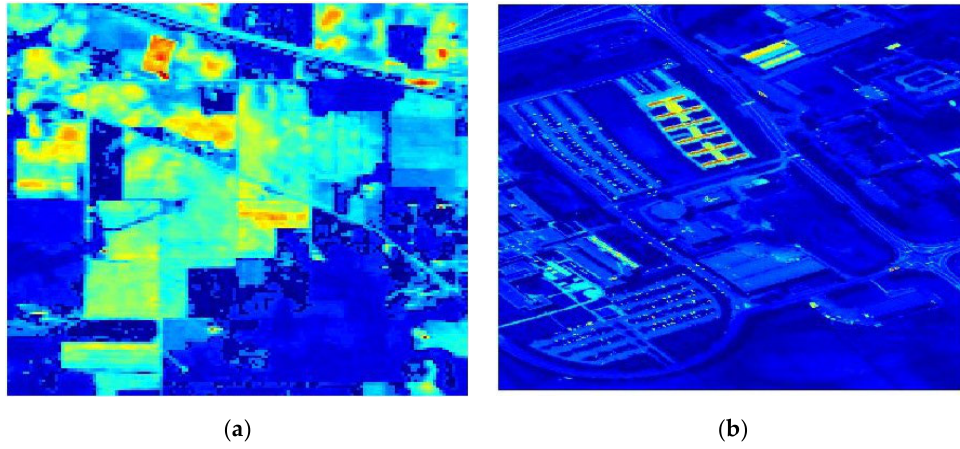
Figure 2. Input Images for: ( a ) Indian Pines and ( b ) Pavia University.